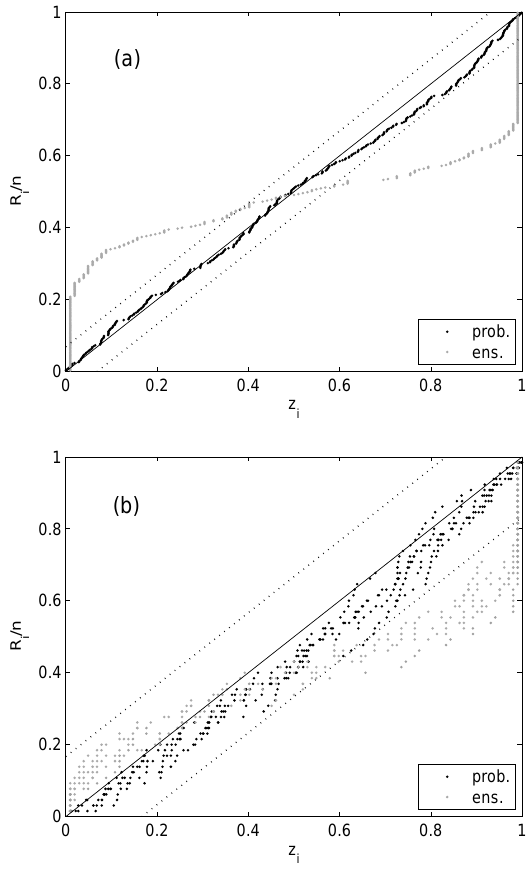
Fig. 5. Probability plot representation (see Fig. 2) of the ensemble (gray circles) and probabilistic (black circles) forecasts of an hourly discharge time series. Each point in the diagram corresponds to a point in the testing set. Panel (a) refers to 1 step-ahead predictions, panel (b) to 6-steps ahead forecasts. The Kolmogorov 5% signifi- cance bands are also reported as dashed